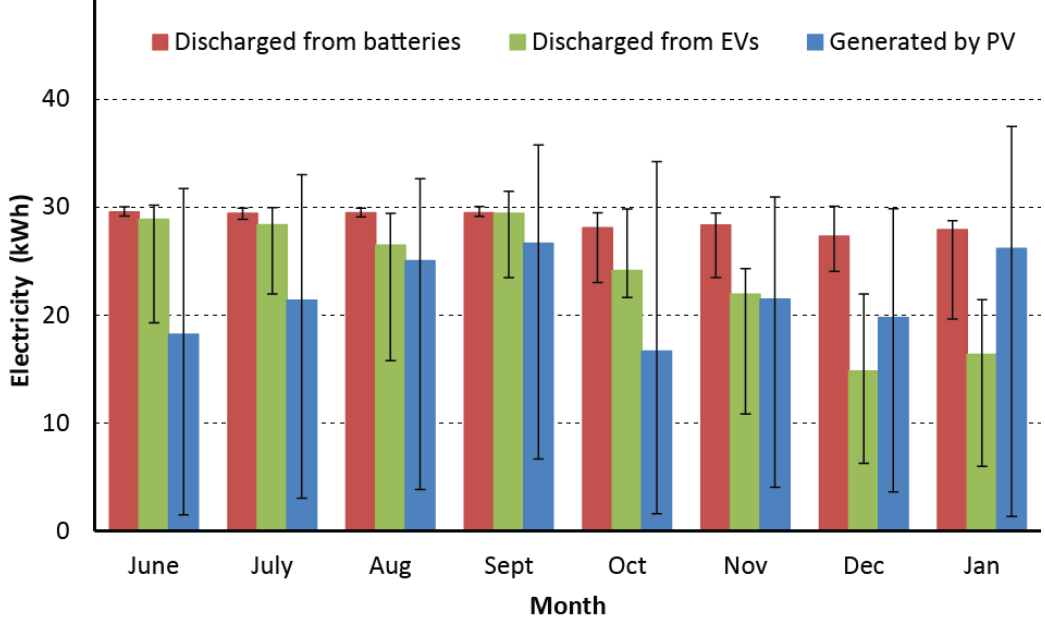
Figure 11. Average total load leveling by each PV, EVs, and used EV batteries in different